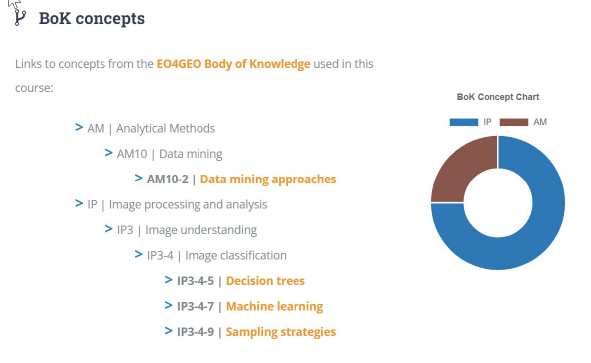
Figure 9 . BoK concepts representing the subjects associated with the training material on Decision Trees. The BoK Concept Chart indicates the major domains to which the associated concepts belong (IP = Image Processing and Analysis; AM = Analytical Methods).